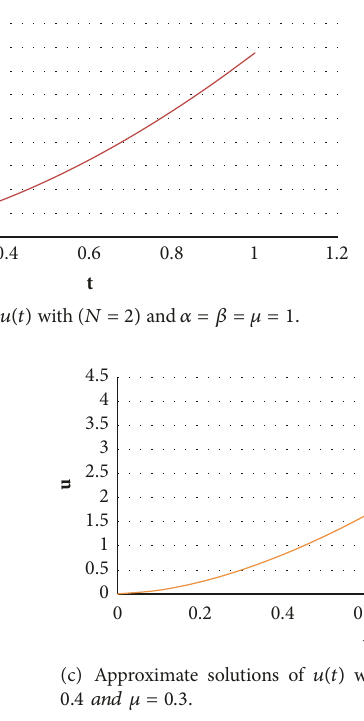
Figure 2: Display the exact and approximate values of control input u(.) with different types of 𝛼, 𝛽 , 𝜇